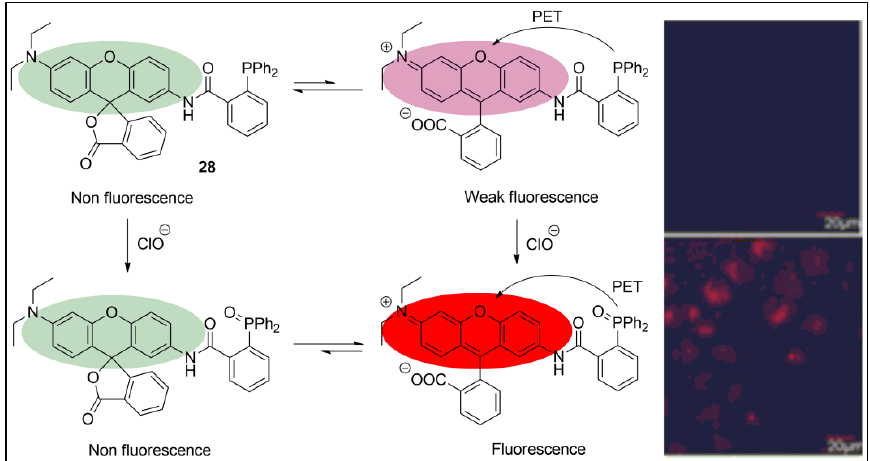
Figure 27. Proposed structural interconversions of probe 28 before and after the addition of ClO - . Confocal fluorescence images of living L929 cells incubated with 28 (3 μ M) for 1 h (upper panel) and additionally treated with ClO - (9 μ M) for 30 min (lower panel). Red channel at 574 – 638 nm. λ EX = 488 nm, Scar bars 20 μ m. Adapted with permission from [100]. Copyright (2017) Elsevier.